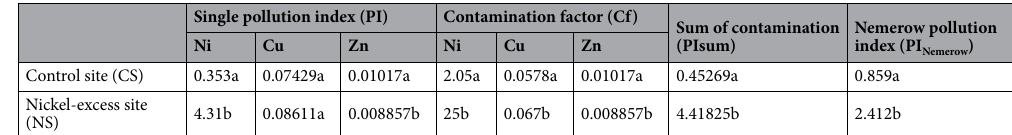
Table 2. Single pollution index (PI), contamination factor (Cf), sum of contamination (PIsum) and Nemerow pollution index (PI Nemerow ) of nickel-excess (NS) and control sites (CS). For the PI and Cf, concentrations of Ni, Cu and Zn measured in the CS and NS ( n = 5) were compared with their respective world mean value 37 . PIsum was calculated using the geometric mean of PI of each metal in the CS and NS. Different letters (a and b) within a column indicate significant differences from each other in all combinations (Tukey’s test, P ≤ 0.05).